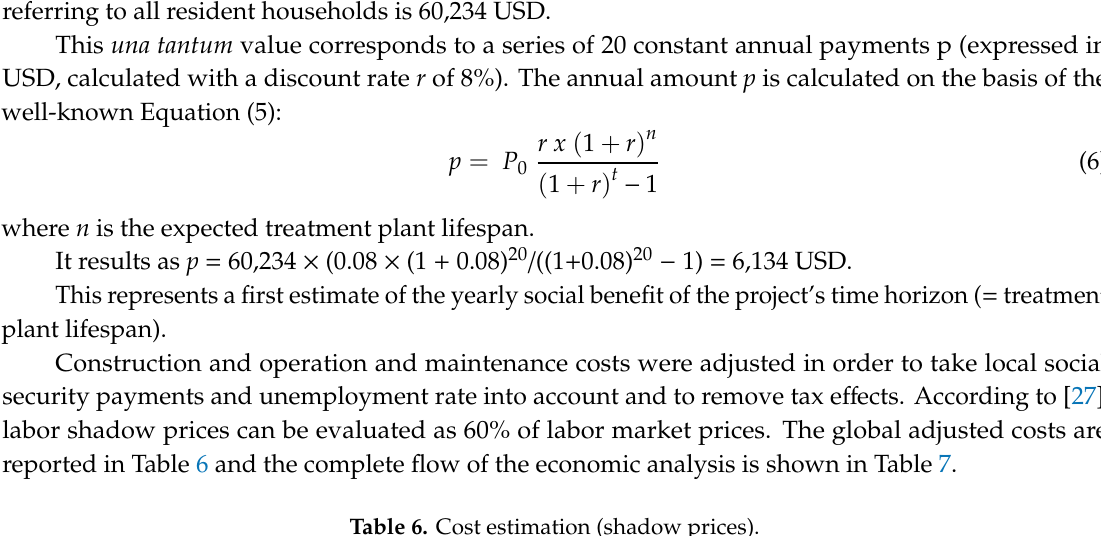
Table 6. Cost estimation (shadow prices).